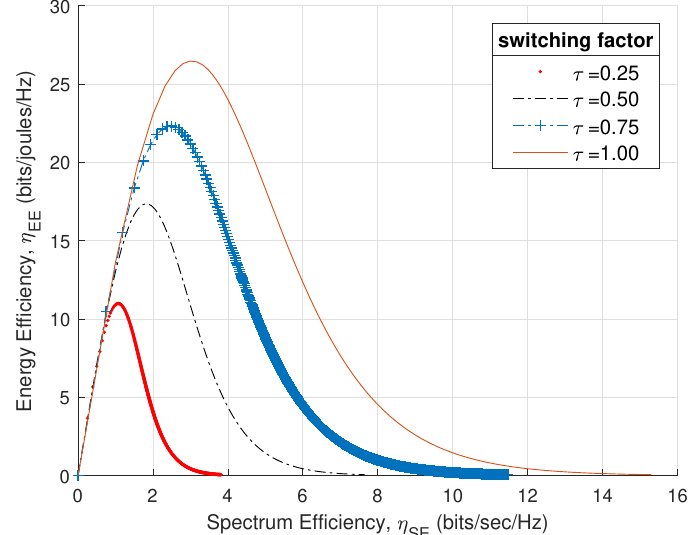
Figure 5. SE vs. energy efficiency (EE) trade-off in time switching (TS)